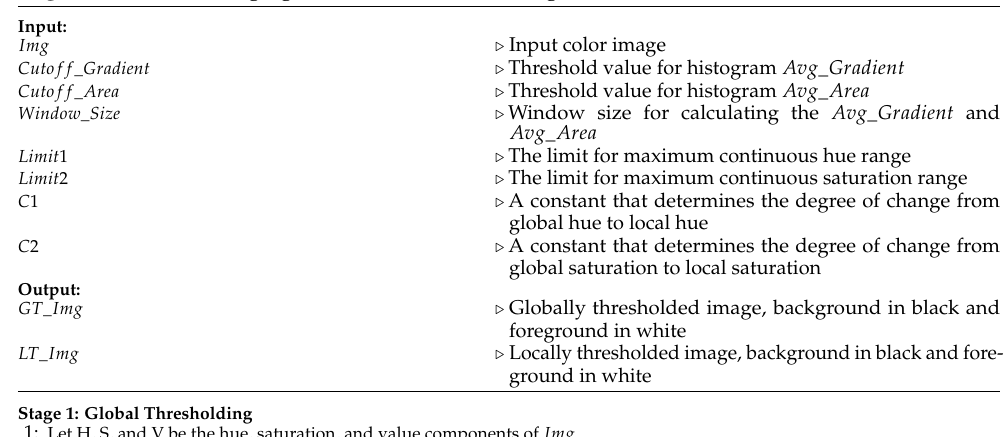
Algorithm 1 Two-stage global–local